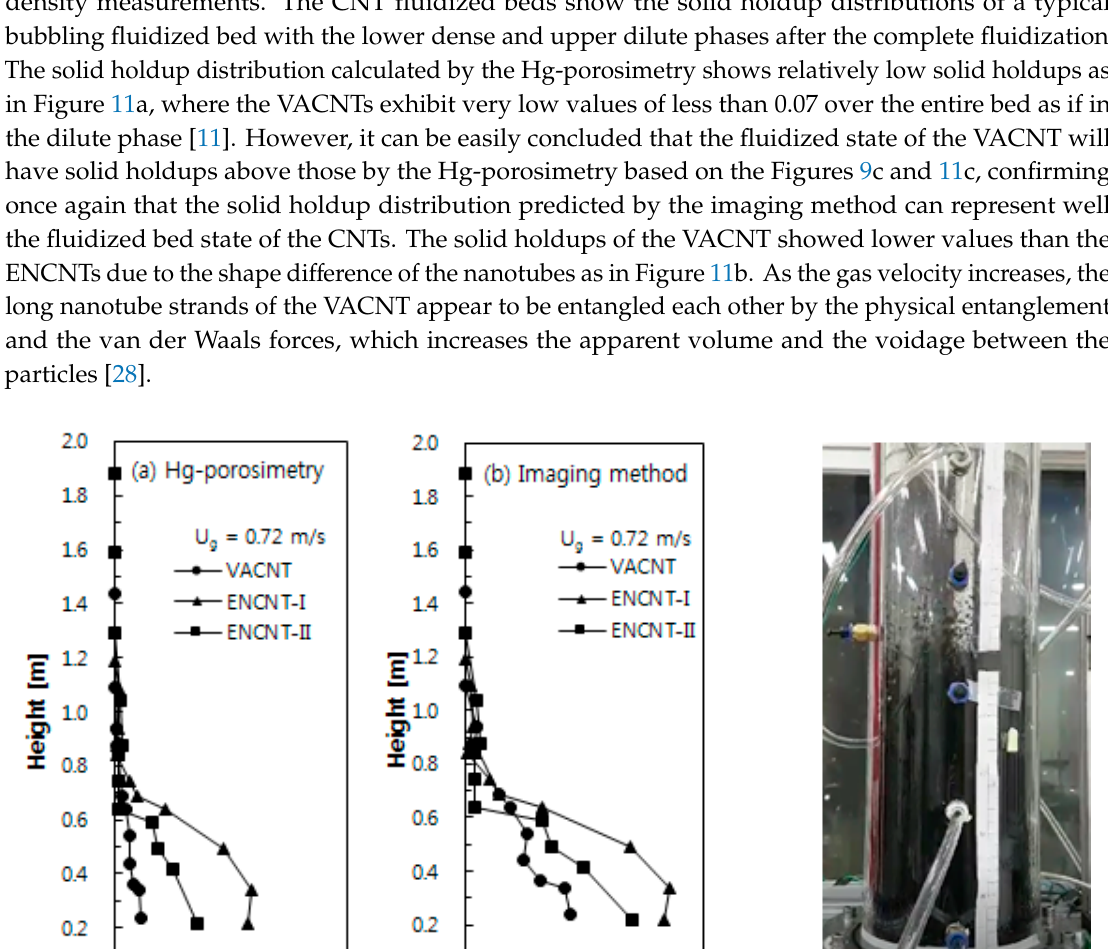
Figure 10. Comparison of solid holdup values at minimum fluidization.